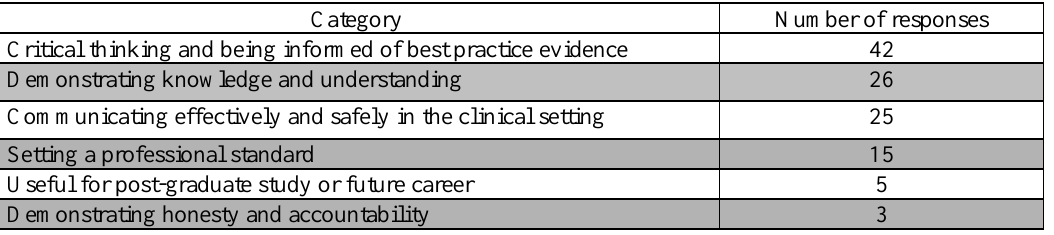
Table 1: Reasons for positive view of relevance of academic